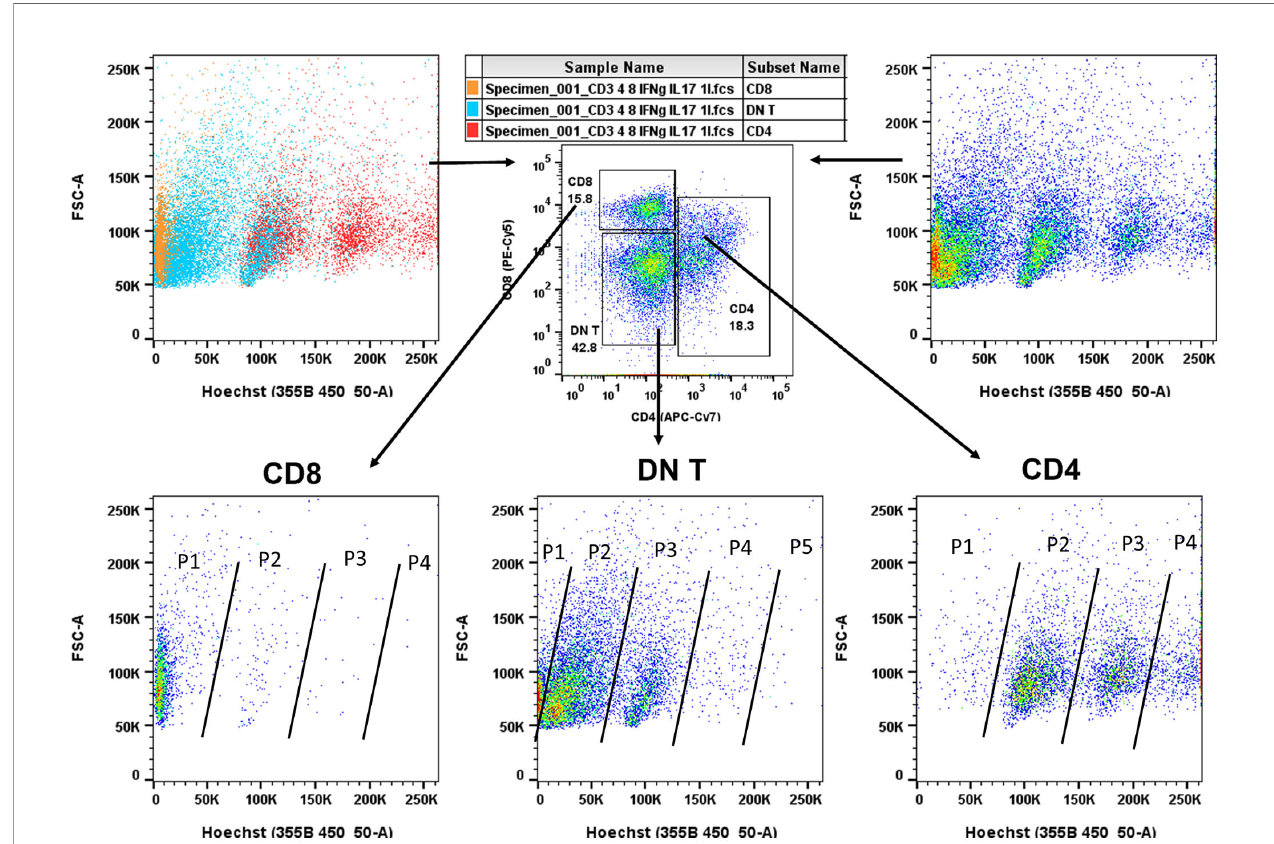
FIGURE 3 | Flow cytometry of Fine Needle Aspiration (FNA) aspirates. Pseudo-color dot plots of lymphocyte specimens from representative FNA aspirates of patients with papillary thyroid cancer (PTC). First, specimens were gated for CD3 and subsequently sorted for CD4, CD8, and DN T cells. Lymphocytes were also stained with Hoechst 33342 (DNA staining to follow DNA replication cycle, top panels, left, cell type colored, right, cell proliferation colored). As shown (bottom panels), DN T (middle)- cell population was predominant and in high DNA replicative state as compared to cytotoxic CD8 T (left)-cell population (P1 – P5, Population cycle). Although CD4 T (right) cells were also in high DNA replicative state, the proportion of proliferating cells was lower at each replicative cycle (P1 – P4) compared to DN T populations (P1 – P5). Of note, CD4 T-cell populations (P1 – P4) include proliferating Treg cell population known to be present in the tumor microenvironment as previously reported (14). Although we observed a considerable proportion of cytotoxic CD8 T cells, their proliferative capacity was limited may be because of a high DN T regulatory-cell